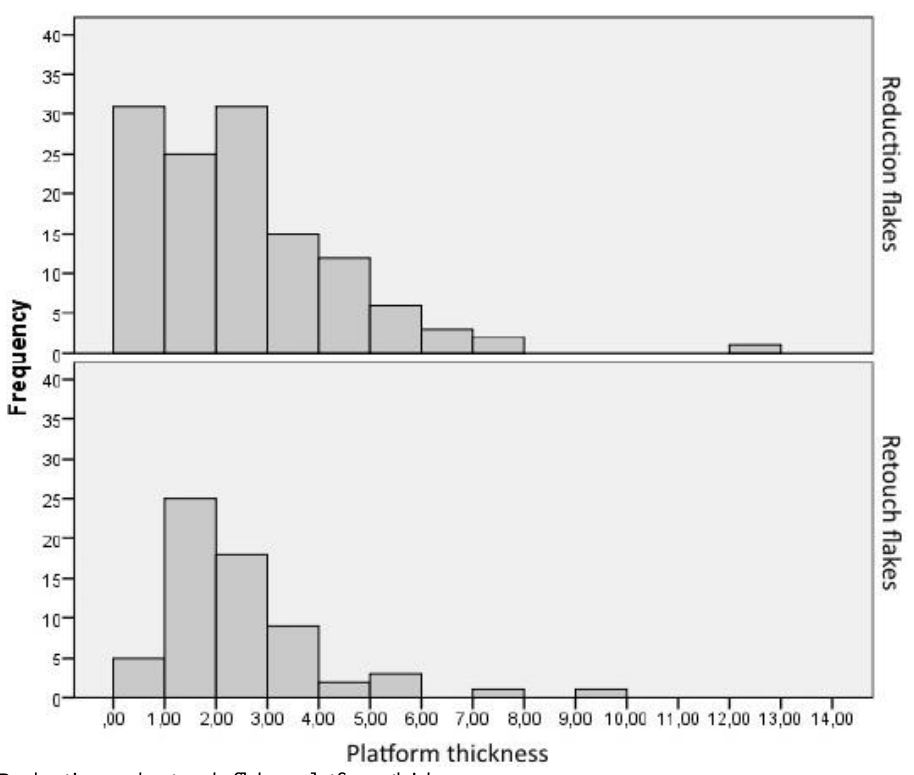
Figure 11. Reduction and retouch flakes platform